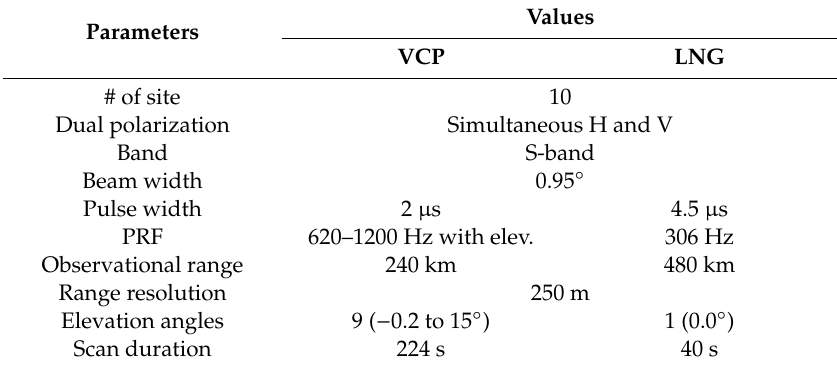
Figure 1. S-band operational radar network of Korea meteorological administration (KMA). Coverages indicate the observation areas for volume and long-range scans; red marks represent the KMA radar sites. Table 1. Characteristics of the S-band dual-polarization radars operated by the